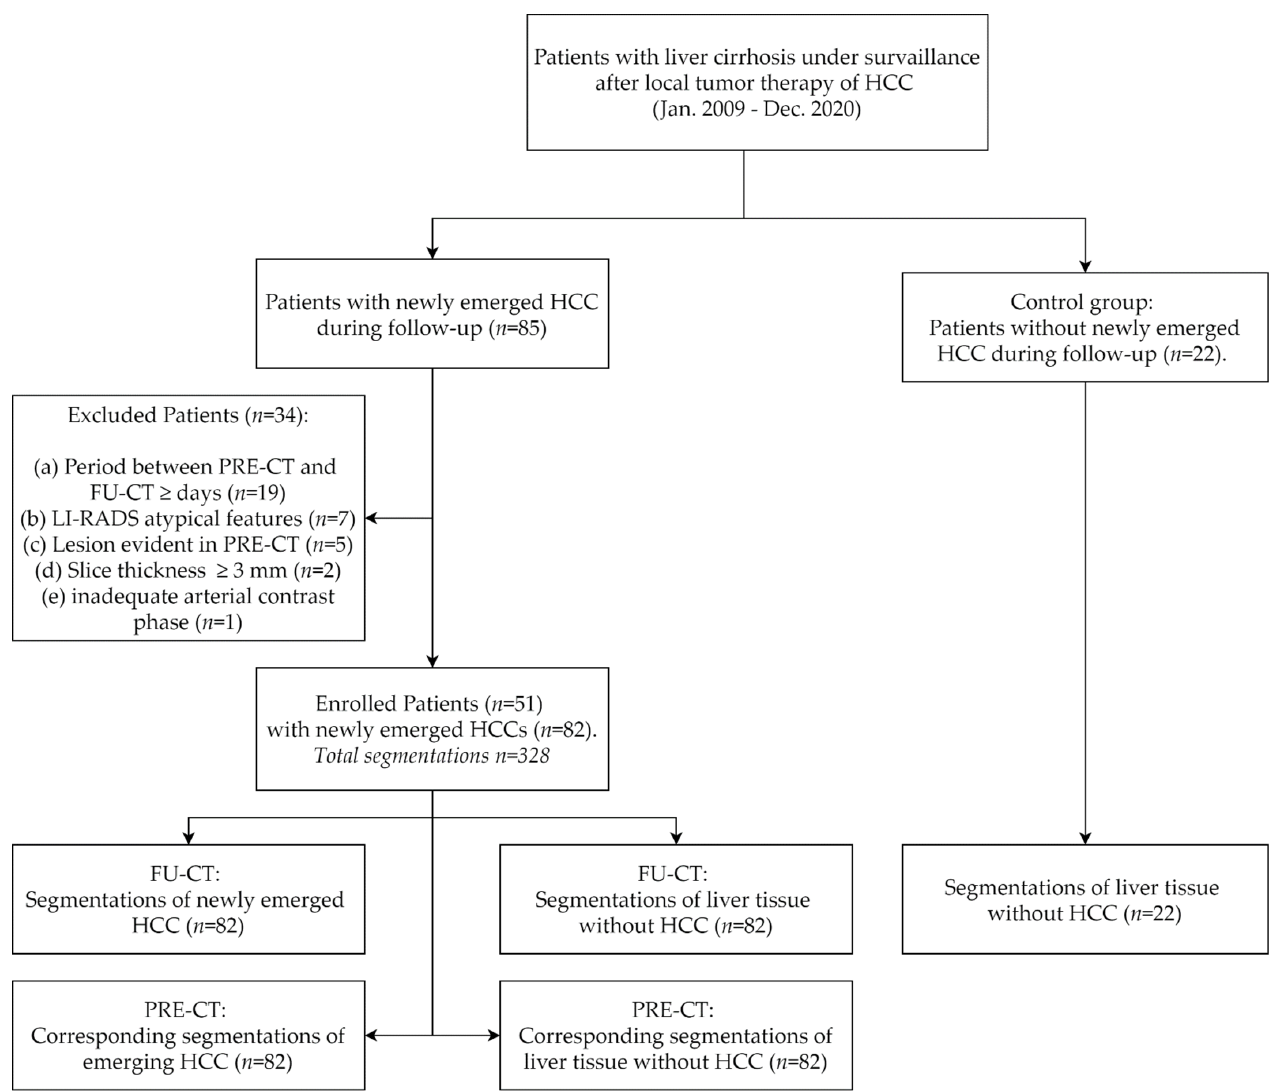
Figure 1. Flow chart of enrolled patients in the study and segmentations derived therefrom. HCC—hepatocellular carcinoma; PRE-CT—computed tomography prior to detection of a newly emerged HCC, FU-CT—follow-up computed tomography at the time of detection of a newly emerged HCC.